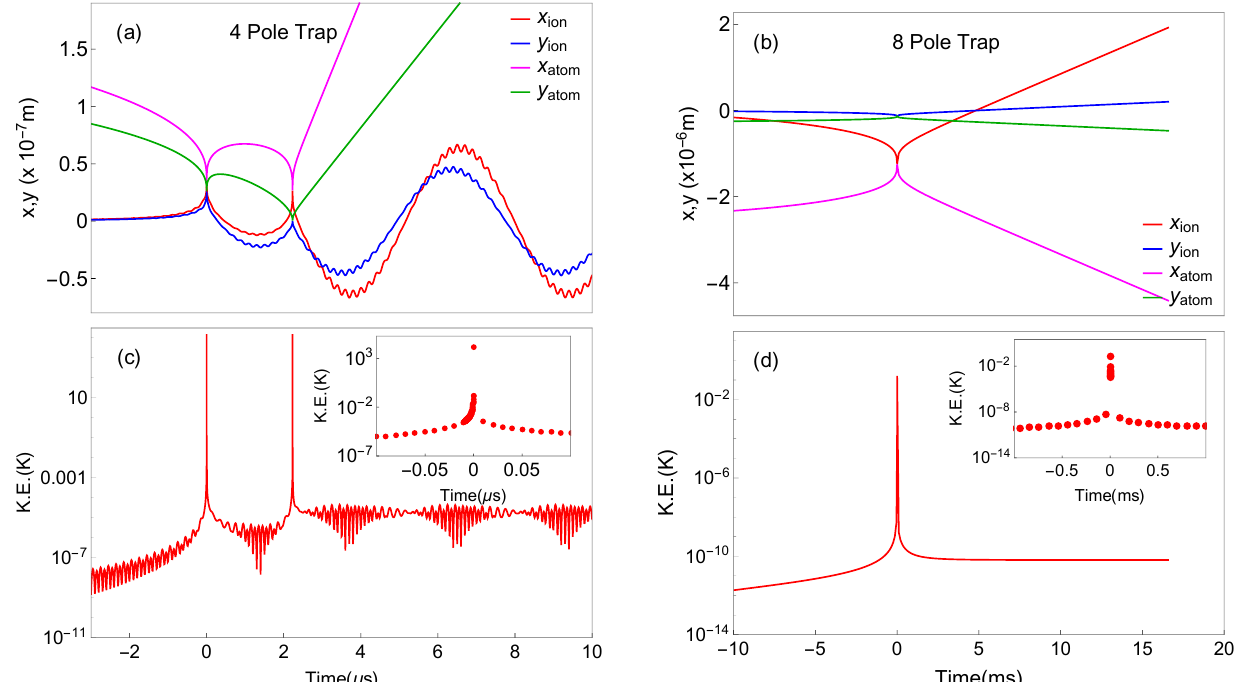
Figure 2. The time domain collision between a trapped and compensated stationary ion, initially located at the center of a quadrupole ( a ) and octupole ( b ) trap, with a stationary atom in its vicinity is shown. The calculation is two-dimensional. As a result of the mutual attraction of the trapped ion with the atom, in the presence of the trapping field, post collision, both the ion and the atom gain kinetic energy. The amount of kinetic energy gained in the collision in ( a , b ) is illustrated in ( c , d ),